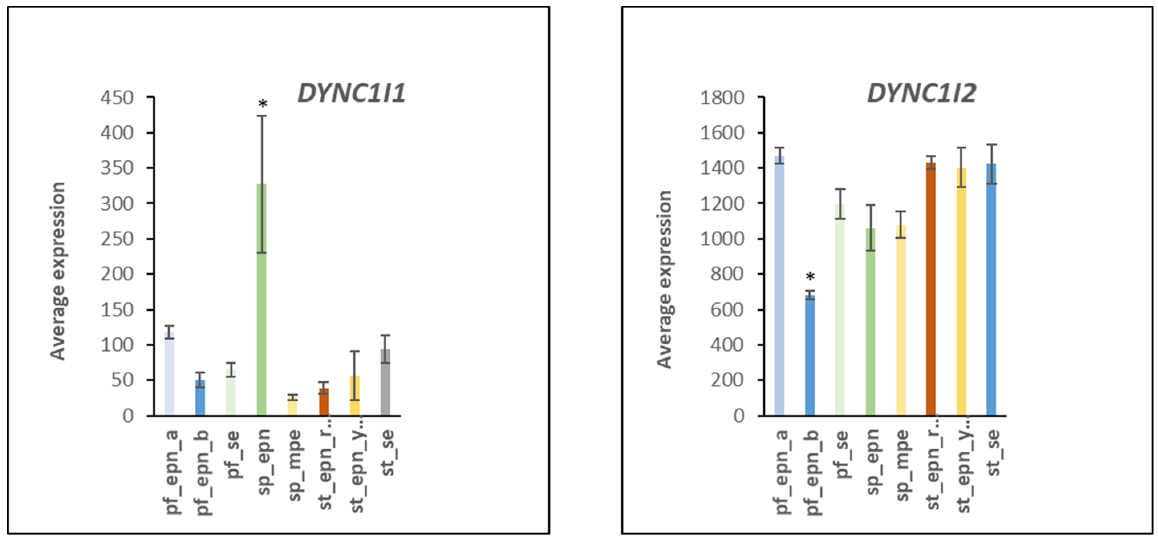
Figure 21. Differential expression of genes encoding E3 ligase adaptors associated with the dynein motor complex (by Anova, F = 13.835, p = 1.38 × 10 − 14 ; F = 27.89, p = 1.38 × 10 − 14 ). * by t -test DYNC1I1 expression is elevated in the SP_EPN group p < 0.05, while DYNC1I2 expression is significantly lower in the PF-EPN-B group p < 0.001, compared to each of the other groups. Dataset GSE64415. Three genes encoding for E3 ligase adaptors were identified by the Reactome pro- gram as genes in the heatmap of Figure 15 that encode for components of the APC/c ubiq- uitin ligase complex, including ANAPC1 , ANAPC5 , and ANAPC7 . These genes are associ- ated with the degradation of cell cycle proteins Cyclin A, Cyclin B, and securin. We sug- gest a role for the APC/c complex in EPN oncogenesis and implicate dysregulation of the APC/c complex as a contributor towards a subtype dependent EPN pathogenesis. This is supported by data showing that UBCH10 (UBE2C) initiates ubiquitination of the APC/c ubiquitin E3 ligase complex [14–16] and that the expression of UBE2C , UBE2S and ANAPC1 , are elevated in the ST_EPN_RELA subtype (Figure 3). 4. Discussion Our analysis of the EPN data sets identified several genes encoding ubiquitin E1 ac- tivators, E2 conjugases, and E3 ligases and adaptors of the UPS pathway that were highly differentially expressed in specific EPN subtypes. GO and Reactome analyses provided valuable information on a diverse set of probable biological pathways supported by the UPS genes in EPN subtypes. 4.1. Setting the UPS Stage: Ubiquitin E1 Activator Forming a heterodimer with NAE1 that activates and transfers NEDD8 to ubiquitin conjugases (Figure 16), the ubiquitin activator UBA3 (aka Neddylation activating enzyme NAE2) was significantly elevated in the ST_EPN_RELA subtype (Figure 1). This may sug- gest a particular involvement of UBA3/NAE2 gene product in enhanced activation of NEDD8 in the ST_EPN_RELA subtype. The notion that neddylation is a major pathway distinguishing the EPN subtypes was further supported by our analysis of ubiquitin ligase adaptors (Tables 6 and 7), which were also associated with an aberrant neddylation path- way in some EPN subtypes. In the order of significance, high gene expression of UBA1 , UBA6 , and UBA3/NAE2 were associated with significantly shorter survival times in the French glioma dataset (chi = 26.79, p = 2.3 × 10 − 7 , chi = 21.04, p = 4.5 × 10 − 6 , chi = 8.79, p = 3.0 × 10 − 3 , respectively). TAK-243 is a small molecular inhibitor of the proteins UBA1, UBA6 and NAE, used for cancer treatment in pre-clinical animal models [59,60]. TAK-243 is also